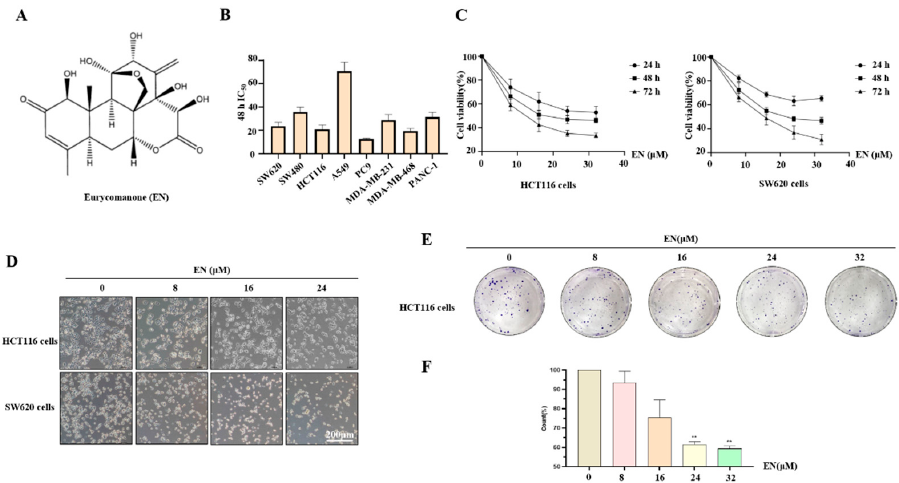
Figure 1. EN inhibits human colon cancer cell proliferation. ( A ) The structure of EN. ( B ) Different cancer cells were treated with EN (0, 8, 16, 24, and 32 μ M) for 24 h, 48 h, and 72 h, respectively, including SW620, HCT116, SW480, A549, PC9, MDA-MB-231, MDA-MB-468, and PANC-1 cells. Cell viability was measured by MTT assay, and the 48 h IC 50 values of EN in different cancer cells were calculated by SPSS 22. ( C ) The viability of HCT116 and SW620 cells was shown under EN treatment for 24 h, 48 h, and 72 h. ( D ) Cells were first seeded into a 12-well plate and then treated with different concentrations of EN (0, 8, 16, and 24 μ M) for 24 h. The morphology and distribution of cells were photographed by microscope. ( E ) HCT116 cells were seeded into a 6-well plate and then treated with EN (32 μ M) for 24 h. When the cell clusters grew to the appropriate size, cells were stained and photographed. ( F ) Image J was used to calculate the number of clones, and it was statistically analyzed by SPSS22. ** p < 0.01.